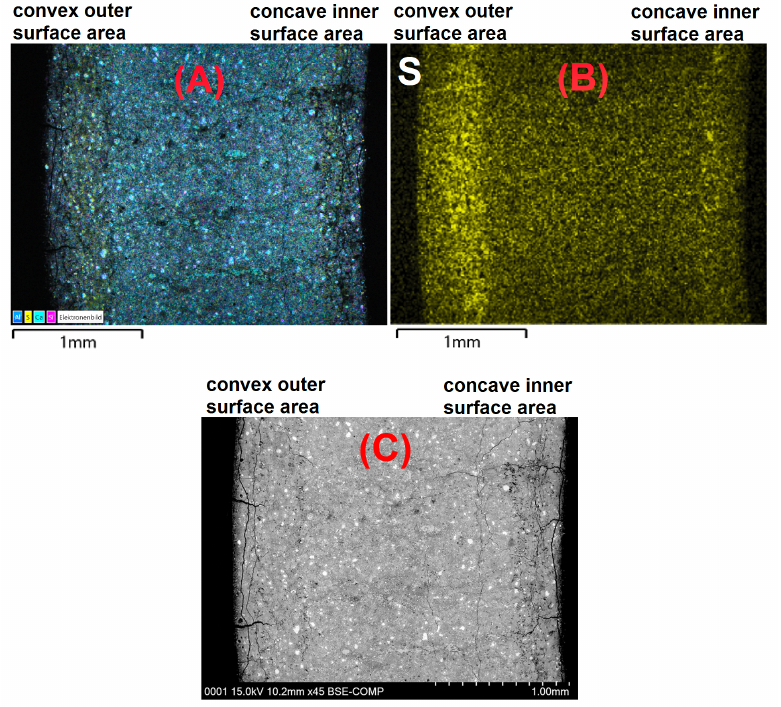
Figure 8. Overlay map ( A ) of a BSE image ( C ) with the EDS element maps of calcium, silicon, aluminium and sulphur and the EDS elemental map of the sulphur content (( B ), solid phases) over the cross-section of hollow cylinder walls (OPC H) at the time of mechanical failure of the samples after 59 days (constrained stress cell) of storage in 3.0gL SO 2– 4